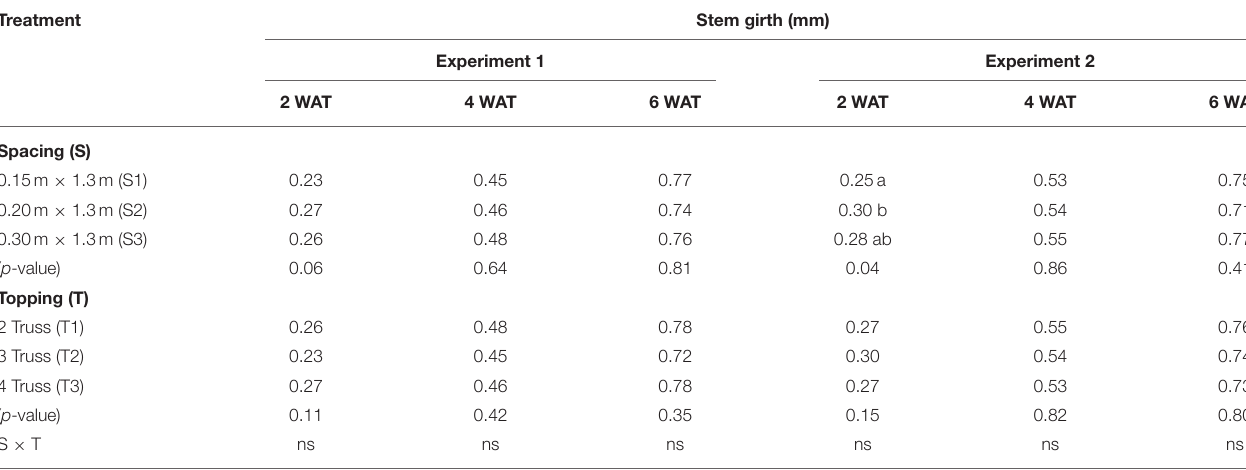
TABLE 3 | Effect of spacing and topping on plant stem girth of Solanum lycopersicum under greenhouse conditions.